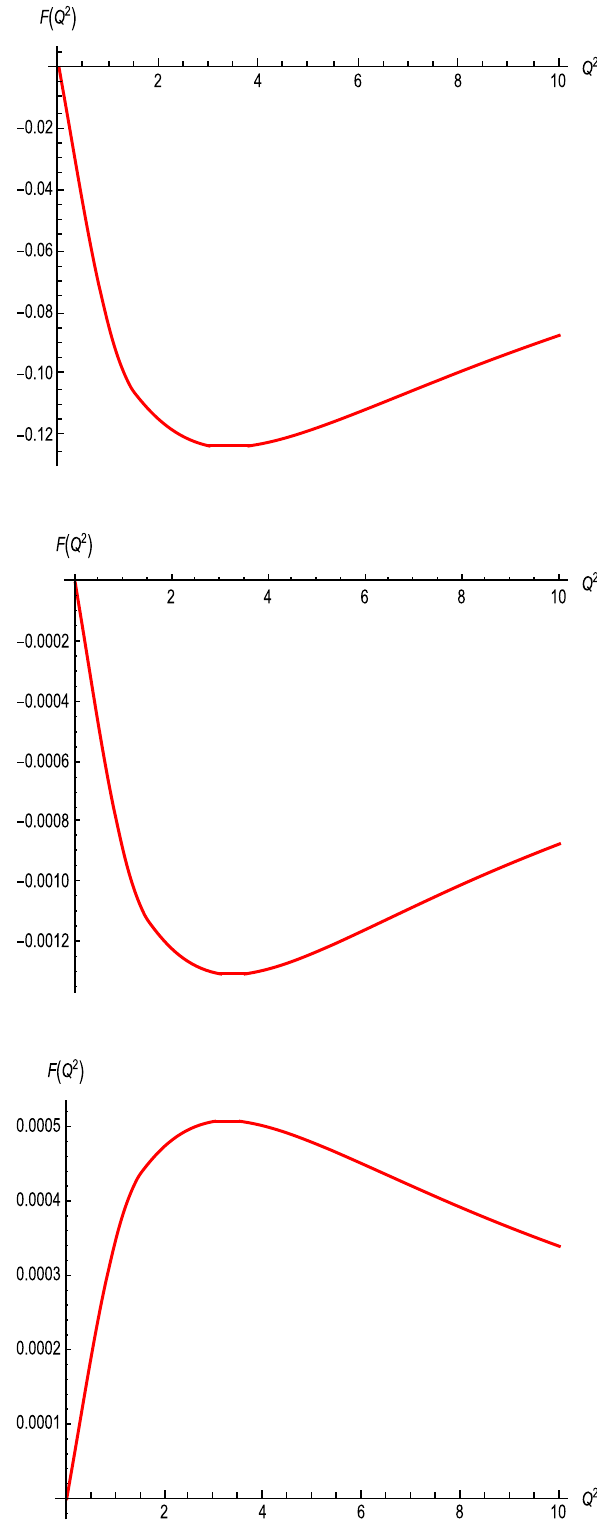
Fig. 18 TransitionformfactorsfromnormalstateNo.1( n = 1 ,κ = 0) to other states listed in Table 1. 1 → 2: No.2 ( n = 2 ,κ = 0, normal) (upper panel); 1 → 3: No. 3 ( n = 1 ,κ = 2, abnormal) (central panel) and 1 → 4: No.4 ( n = 2 ,κ = 2, abnormal) (lower